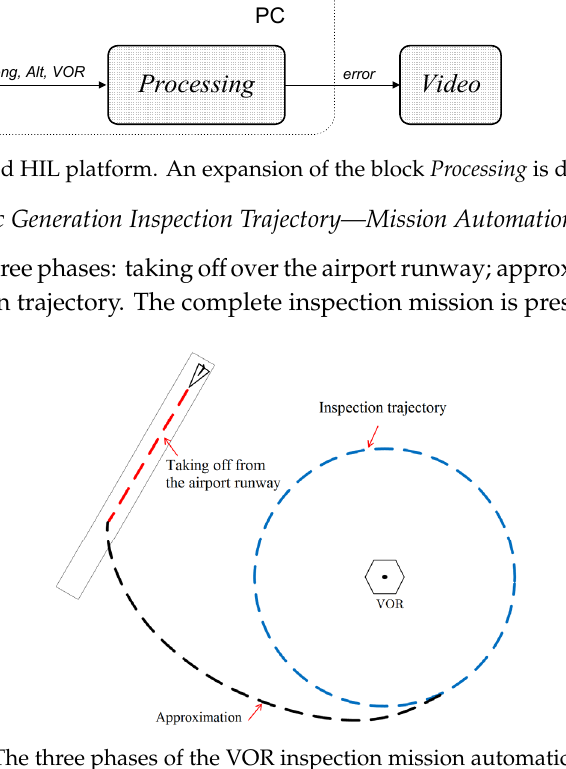
Figure 6. The three phases of the VOR inspection mission automatic trajectory.